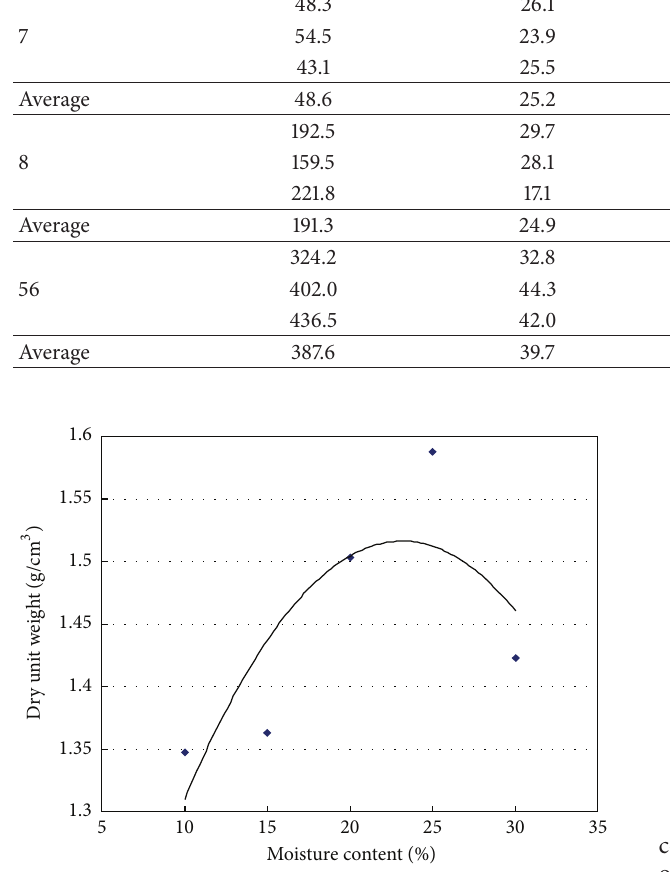
Figure 6: Compaction curve of soil group C.